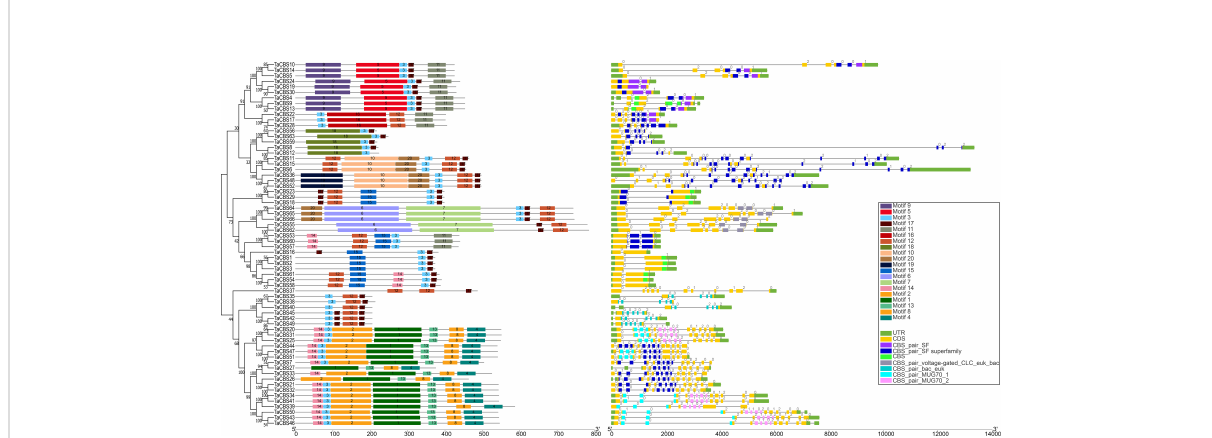
showing a high homology retention rate. The conserved positions of these fragment replication regions located on different chromosomes suggests that fragment replication events play an important role in the expansion of the number of TaCBS genes in wheat.